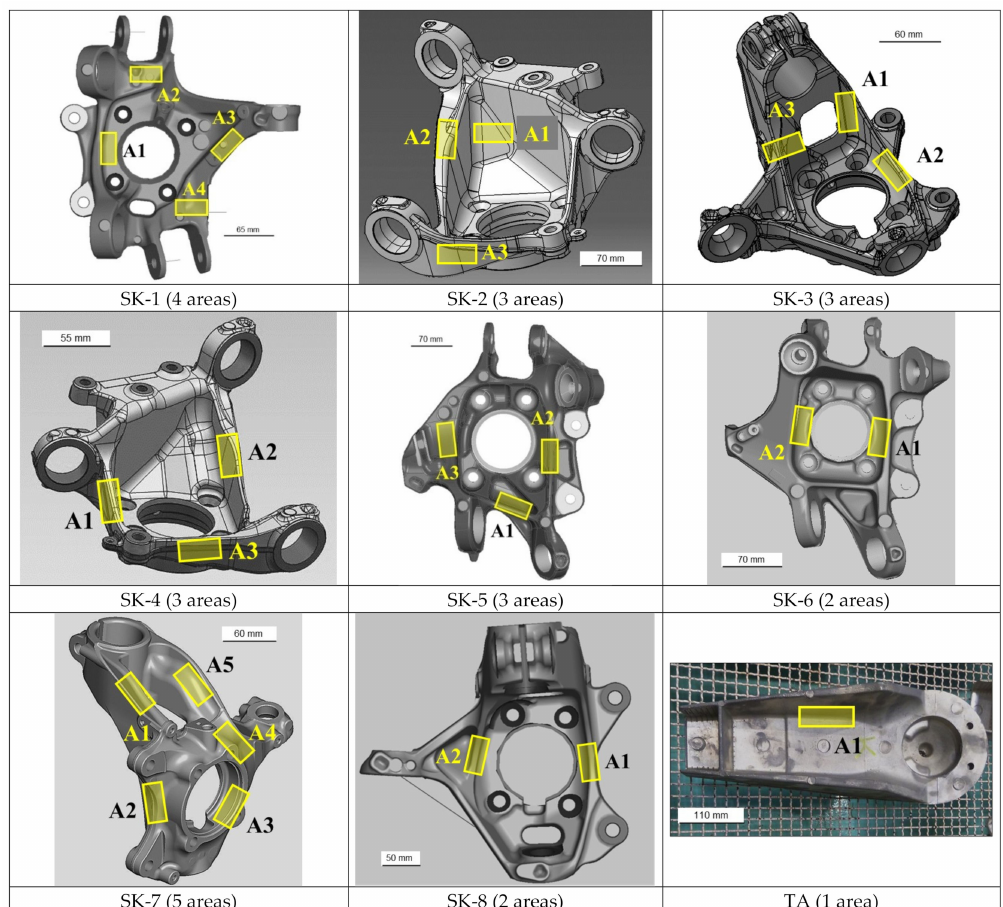
Figure 6. Different characterization areas selected in the industrial castings. The different areas studied in each casting are labeled as A1 to